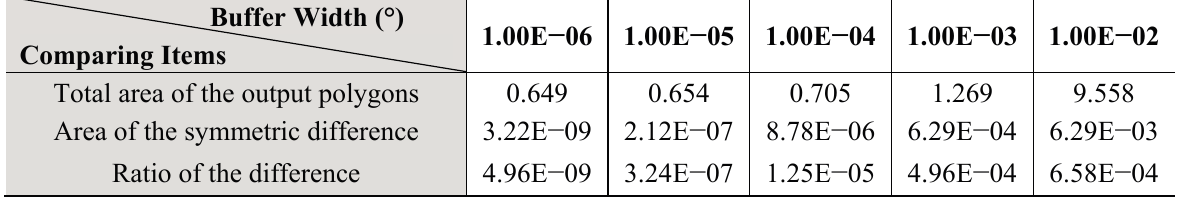
Table 4. Accuracy assessment of the buffer operation for different buffer